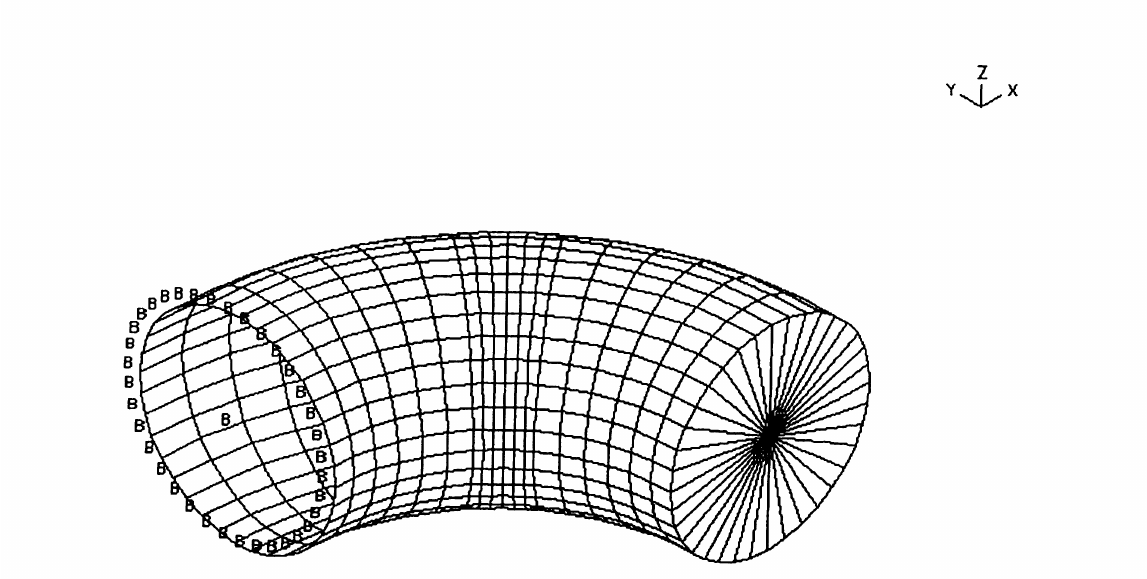
FIGURE 2 Finite element model of a 2-in. Seh. 40 standard elbow with 648 shell